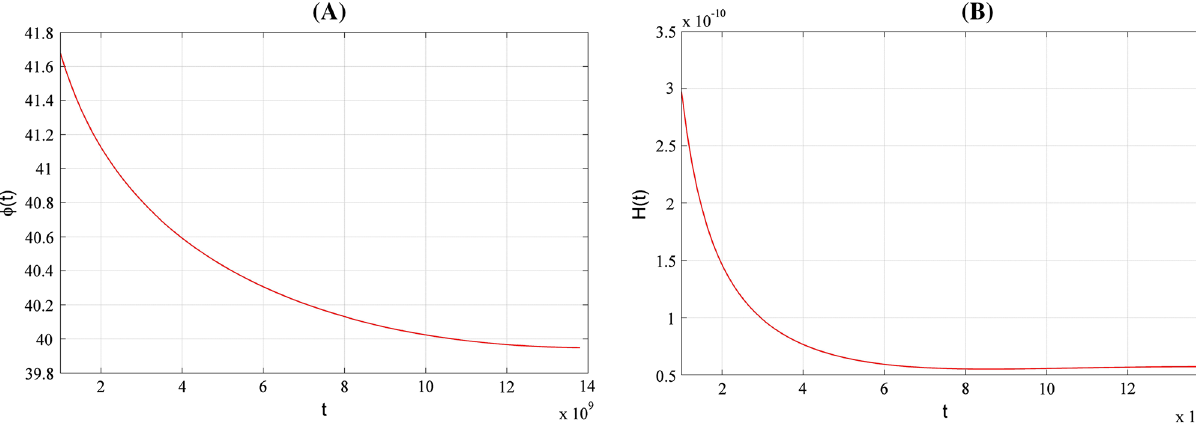
Fig. 2 Plots a and b indicate the scalar field φ( t ) and the Hubble parameter H ( t ) versus time t at the time range [1Gyr, 13.8Gyr],